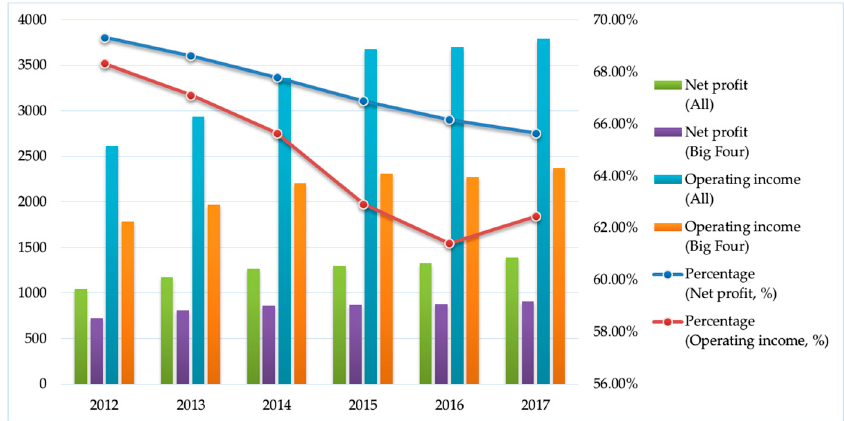
Figure 3. The trends of indicators of all the banks in the sample and the Big Four banks (2012–2017).